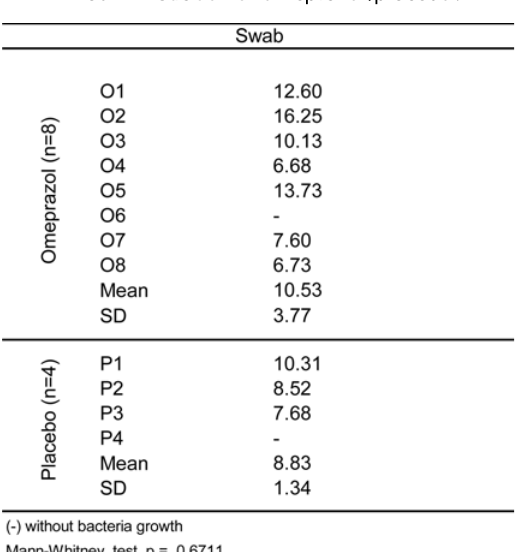
TABLE 3 - Quantity of bacteria [Ln(UFC/mL)] obtained in each sample by swab tecnique after administration of